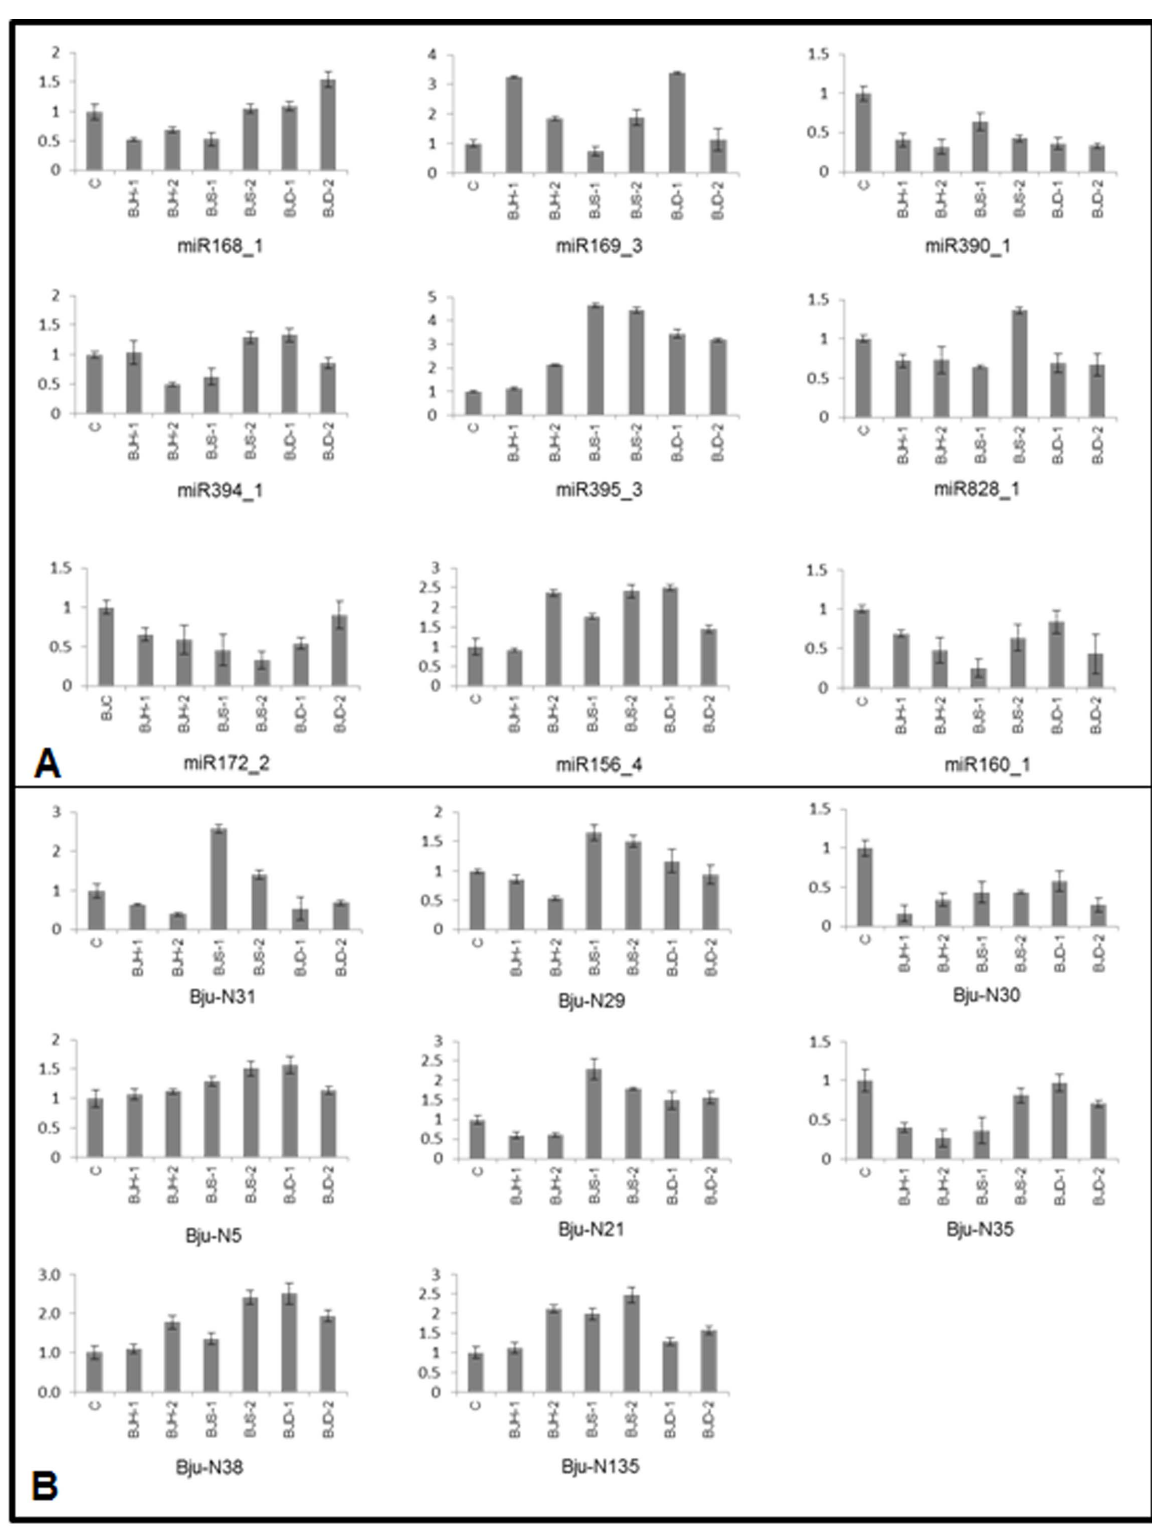
Figure 2. Expression profiling of conserved (A) and novel miRNAs (B) was performed to validate the predicted miRNAs. Quantitative PCR was performed using TaqMan chemistry. The relative abundance (Y-axis) was calculated using the DD Ct method. B. juncea seedlings were subjected for varied durations to either high temperature stress either at 35 u C (BJH-1) and 42 u C (BJH-2) or salinity stress at 150 mM NaCl (BJS-1) and 250 mM NaCl (BJS-2) or drought stress using 20% PEG (BJD-1) and 300 mM mannitol (BJD-2). The mean of three independent biological replicates is presented.